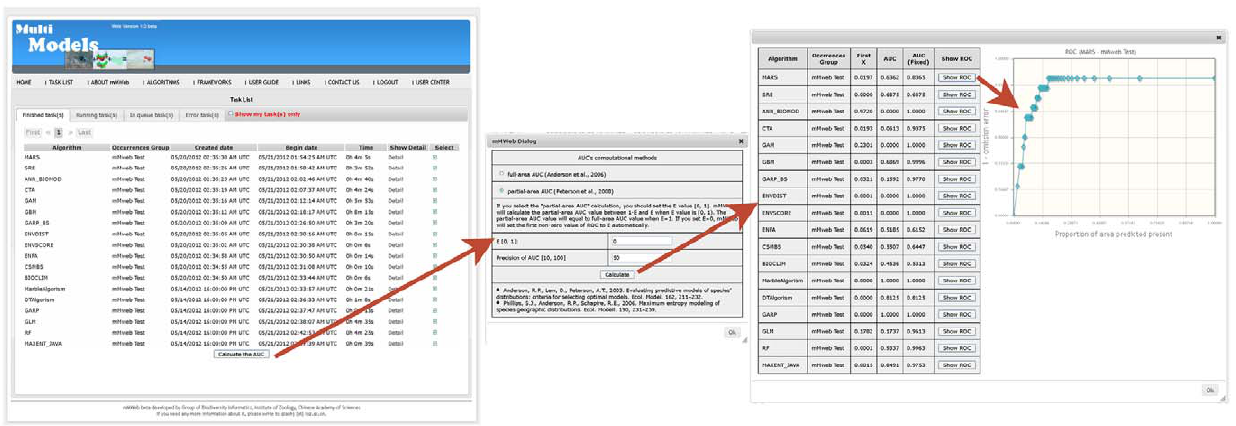
Figure 4. The steps to calculate the AUC value and show the ROC of task(s). 1) Select calculated results, 2) choose AUC method from menu, 3) select parameters, 4) calculate, and 5) show ROC.